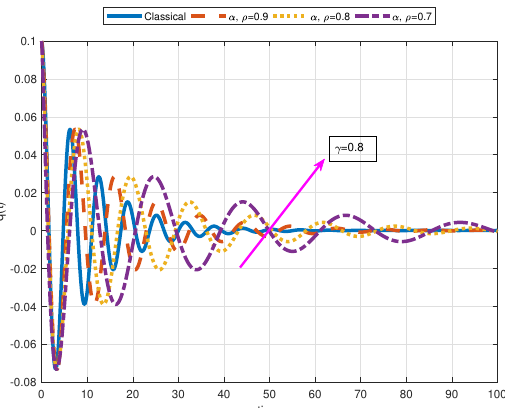
Figure 15. This plot is for the function q ( t ) with respect to the exponential source for some values of α and ρ when γ = 0.8, e 0 = 5 V, L = 10 H, C = 0.1 F, R = 2 Ω , q ( 0 ) = 10, and M D α , ρ , γ q ( 0 ) = 0.